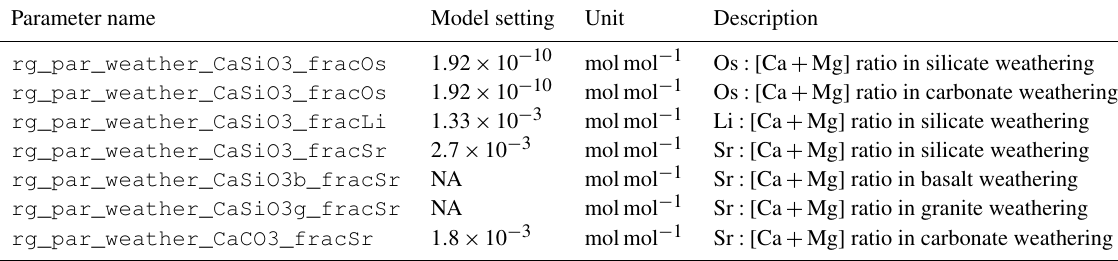
Table E1. Model parameters setting continental weathering-related trace metal fluxes.